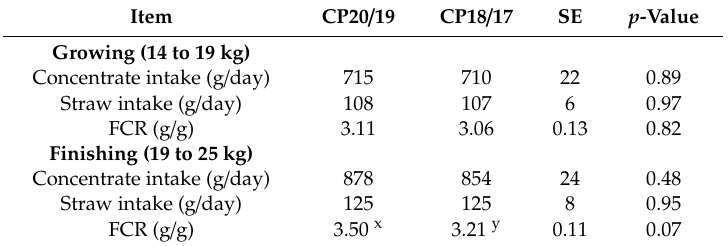
Table 4. E ff ect of Experimental Diets on Average Daily Concentrate and Straw Intake and Feed Conversion Rate